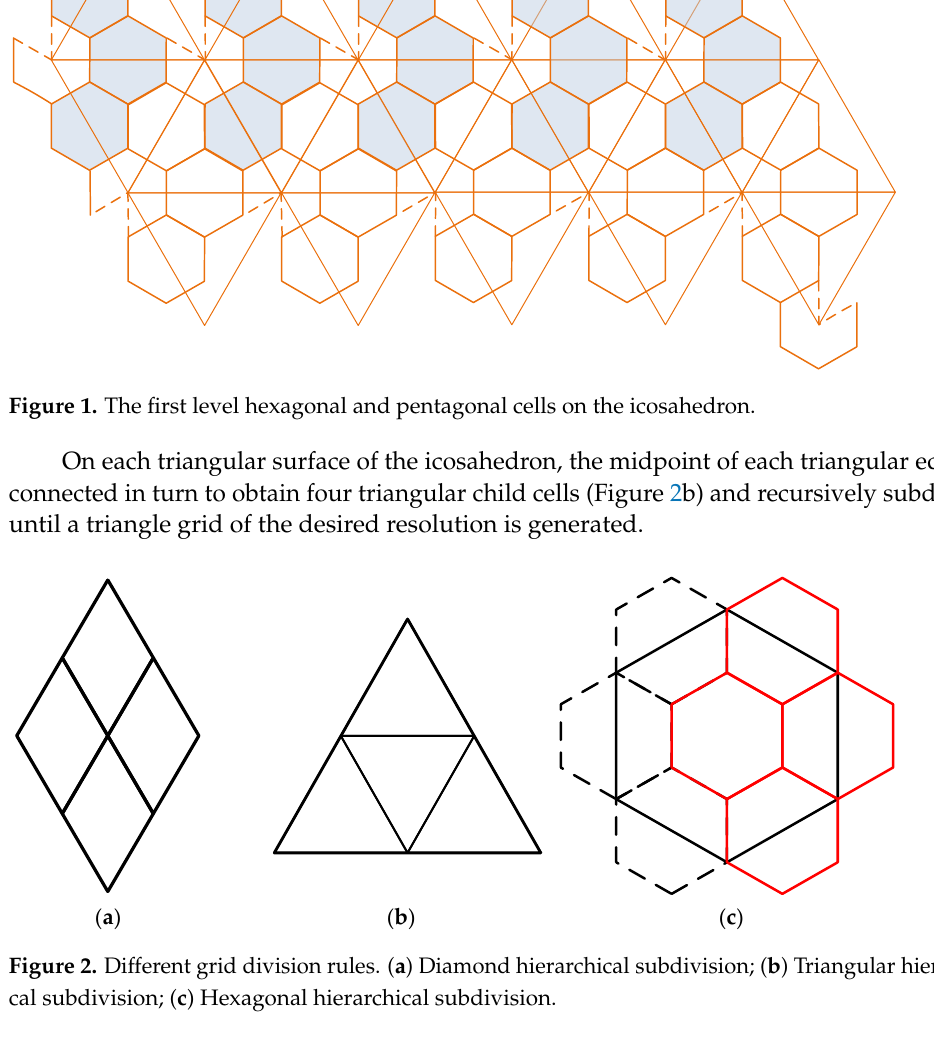
Figure 2. Different grid division rules. ( a ) Diamond hierarchical subdivision; ( b ) Triangular hierarchical subdivision; ( c ) Hexagonal hierarchical subdivision.